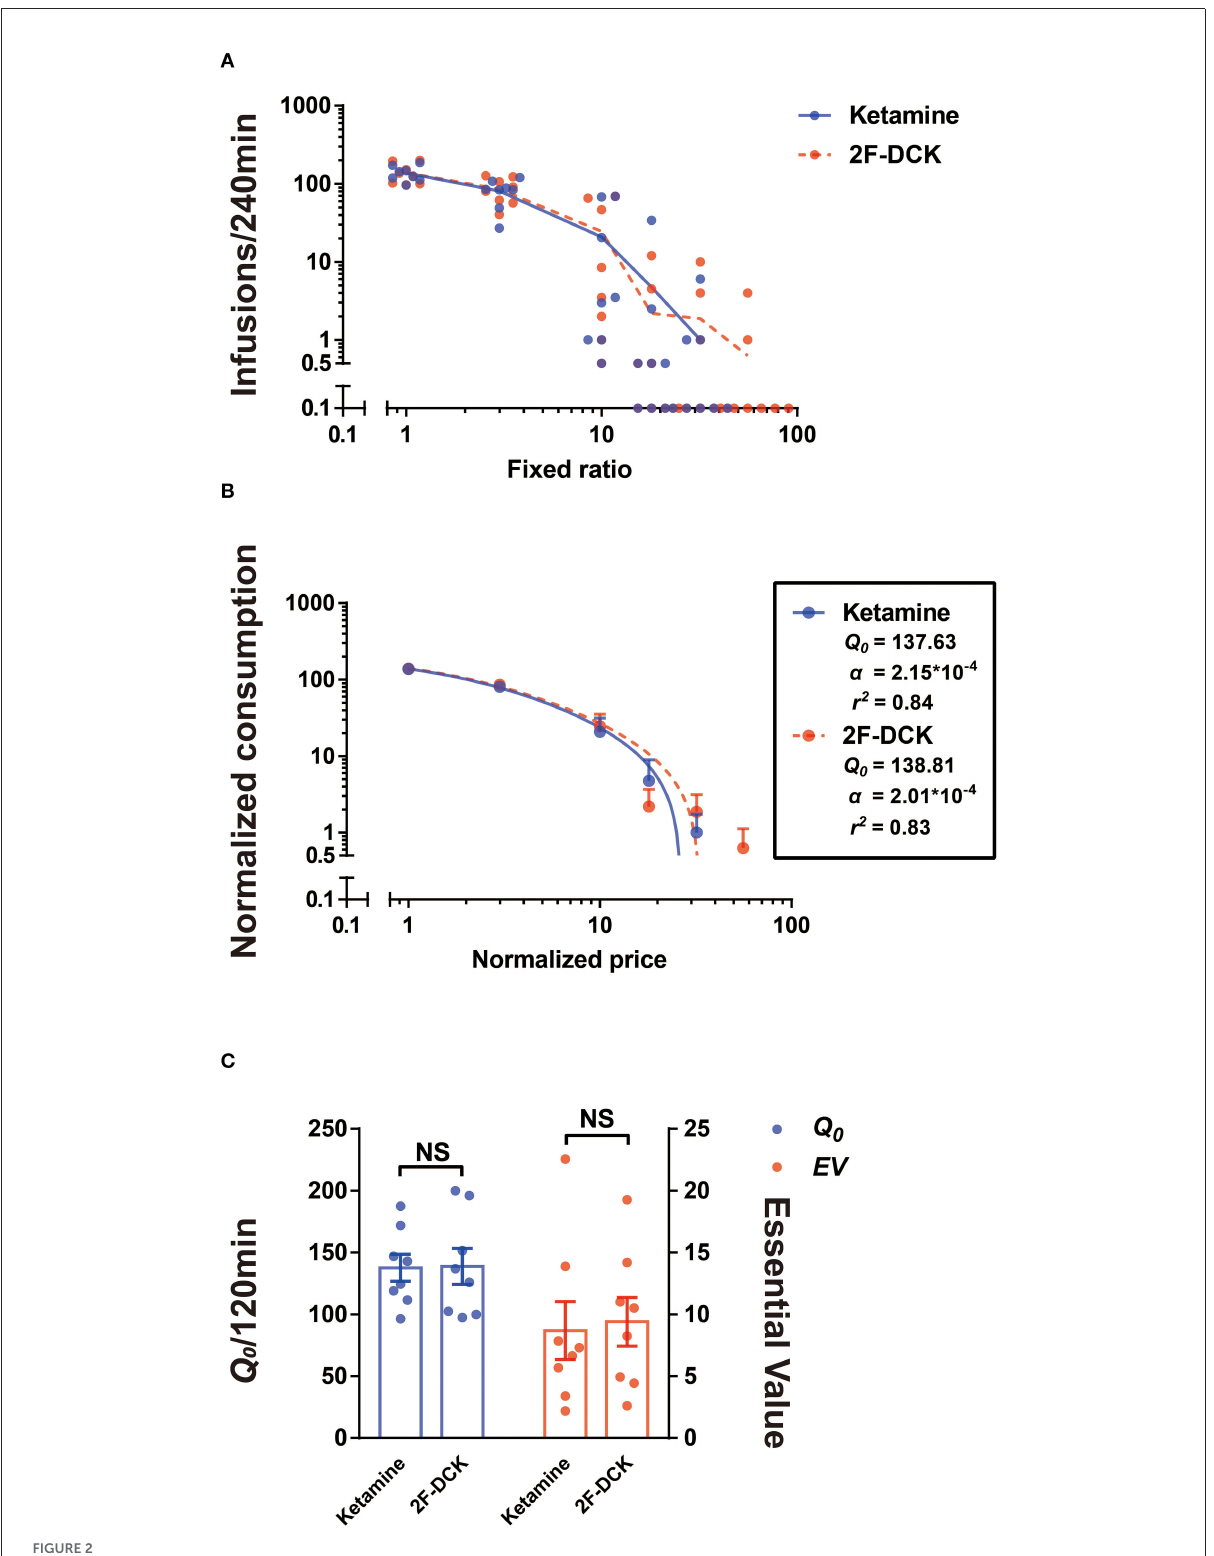
FIGURE2 Demand curve for 2F-DCK and ketamine. (A) Individuals’ demand curves for 2F-DCK and ketamine, in which the number of infusions is plotted as a function of the fixed-ratio requirement on a log scale. (B) Normalized demand curves for 2F-DCK and ketamine, and the abscissa and ordinate use logarithmic scaling. (C) Parameters derived from the demand curve fit for each of the solutions available for self-administration. Estimates of consumption at a minimal cost (Q 0 ; Equation 1) are plotted in the left ordinate, whereas estimates of essential value (EV; Equation 2) are plotted in the right ordinate. NS, not